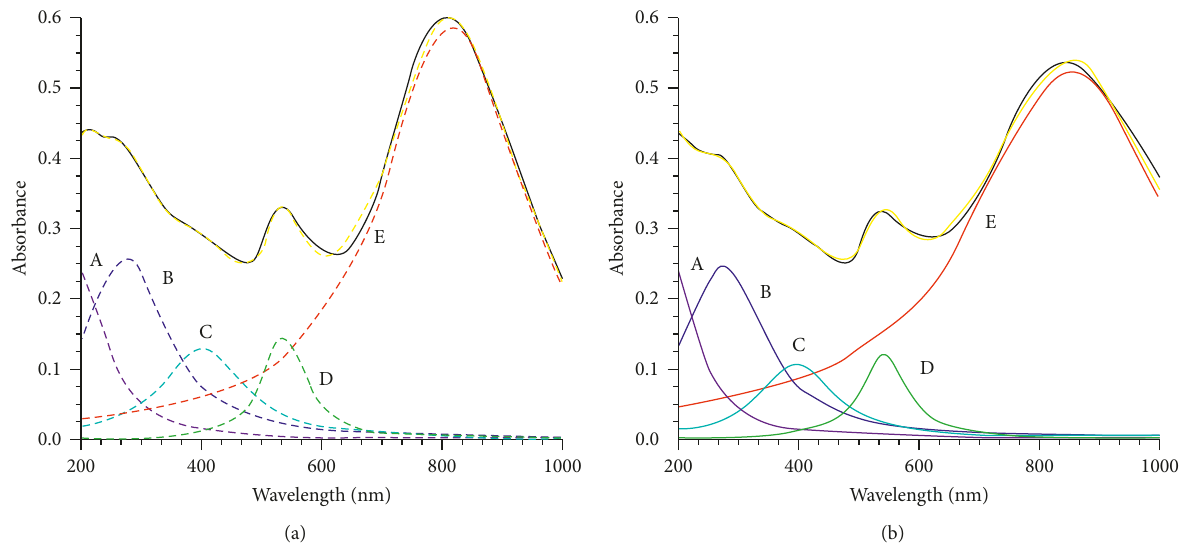
Figure 8: Experimental and decomposed absorbance spectra in the case R experimental spectrum. Yellow line: spectrum reconstructed by adding up the decomposed spectral bands A, B, C, D, and E.